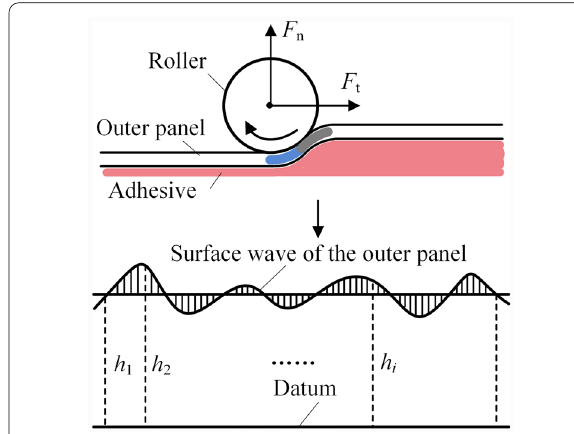
Figure 12 Schematic diagram of force interaction between roller and out panel